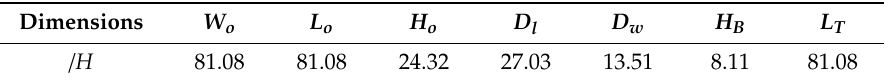
Table 2. Dimensions of computational domain. Figure 5. Computational domain (for Case 3).